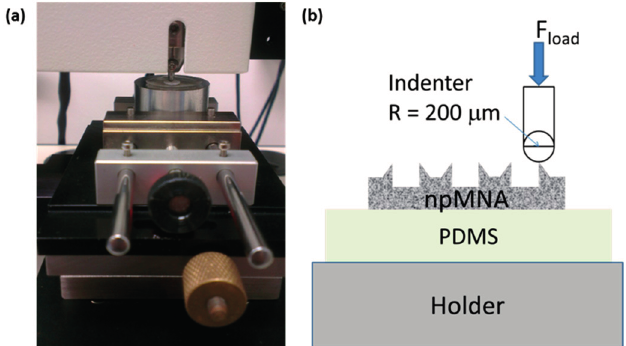
Figure 2. ( a ) CSM microindenter setup showing the sample holder and clamping conditions during indentation; ( b ) Schematic overview of the ceramic npMNA resting on a PDMS rubber pad during application of the load via the